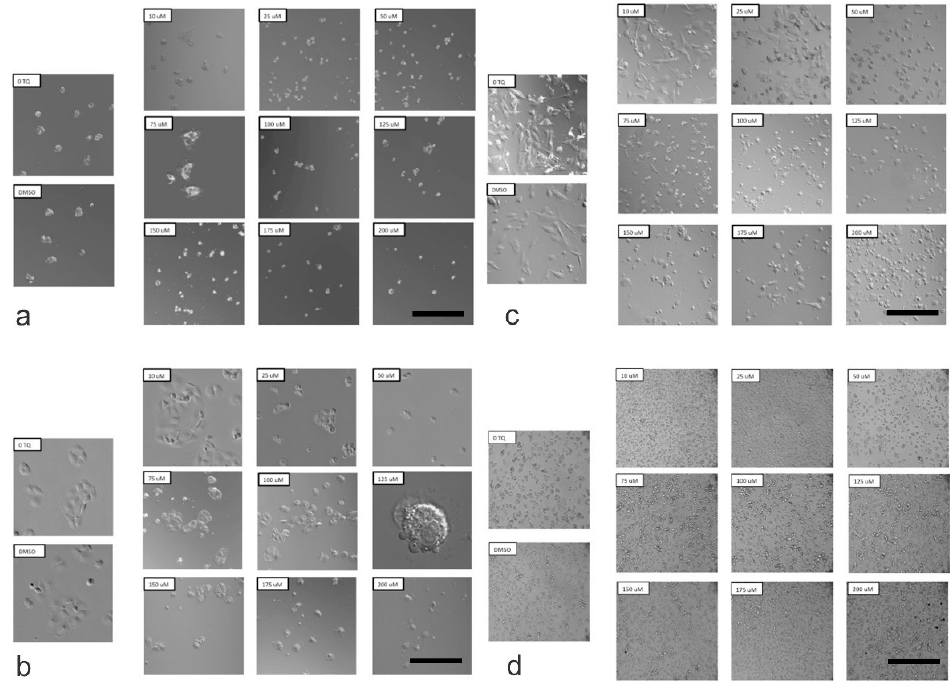
Figure 7. Morphological Alterations Associated with TQ treatments in ( a ) HepG2 cells, ( b ) HuCCT1 cells, ( c ) THLE-3 cells, and ( d ) HEK293T cells by confocal microscopy (scale bar: 50 µm). Confocal microscopy was used to assess the morphological alterations of the HepG2, HuCCT1, and standard THLE-3 cell lines following exposure to different concentrations of TQ for 24 h. HepG2 and HuCCT1 cell lines treated with TQ showed a noticeable reduction in the cell number, which was more evident at higher concentrations of TQ. However, the morphology was little or not altered in the SV40- immortalized hepatocytes (THLE-3) and SV40-immortalized renal epithelial cells (HEK293T). The best representative images of each group are shown. ( a ) comprises up and down of the figure on the left are 0-TQ and DMSO, respectively, and the nine microphotographs from left to right: on the first row, 10, 25, and 50 µM TQ; on the second row, 75, 100, and 125 µM TQ; and on the third row, 150, 175, and 200 µM TQ (scale bar: 50 µm). ( b ) comprises up and down of the figure on the left are 0-TQ and DMSO, respectively, and the nine microphotographs from left to right: on the first row, 10, 25, and 50 µM TQ; on the second row, 75, 100, and 125 µM TQ; and on the third row, 150, 175, and 200 µM TQ (scale bar: 50 µm). ( c ) comprises up and down of the figure on the left are 0-TQ and DMSO, respectively, and the nine microphotographs from left to right: on the first row, 10, 25, and 50 µM TQ; on the second row, 75, 100, and 125 µM TQ; and on the third row 150, 175, and 200 µM TQ (scale bar: 50 µm). ( d ) comprises up and down of the figure on the left are 0-TQ and DMSO, respectively, and the nine microphotographs from left to right: on the first row, 10, 25, and 50 µM TQ; on the second row, 75, 100, and 125 µM TQ; and on the third row, 150, 175, and 200 µM TQ (scale bar: 50 µm). In contrast, untreated cells and vehicle control cells treated with DMSO displayed no observable effects. They were well spread and attached to the surface of the culture dish, with prominent and intact nuclei. Similarly, no effect on the standard HEK293T cell lines was observed after TQ treatment, as confirmed by light microscopic